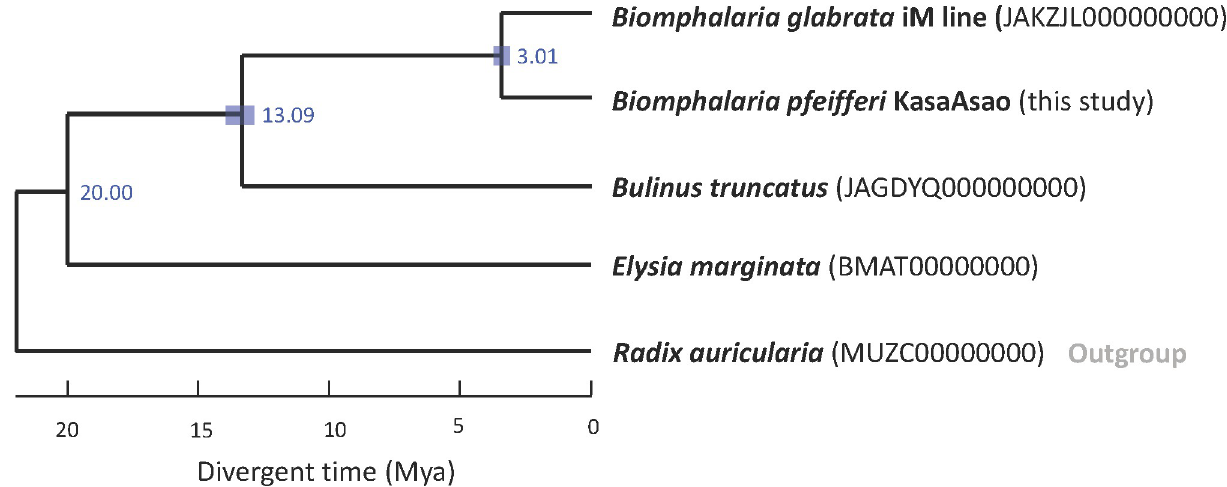
Fig 7. Time tree computed based on species tree with branch length and a constraint point of Bulinus emerging 20 Mya, based on the fossil record. The International Nucleotide Sequence Database Collaboration (INSDC) genome IDs on NCBI were listed in the brackets beside each species.